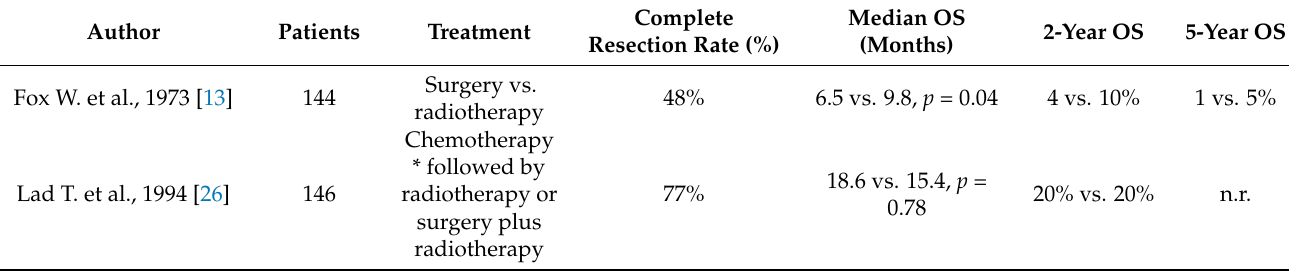
Table 1. Randomized trials evaluating the role of